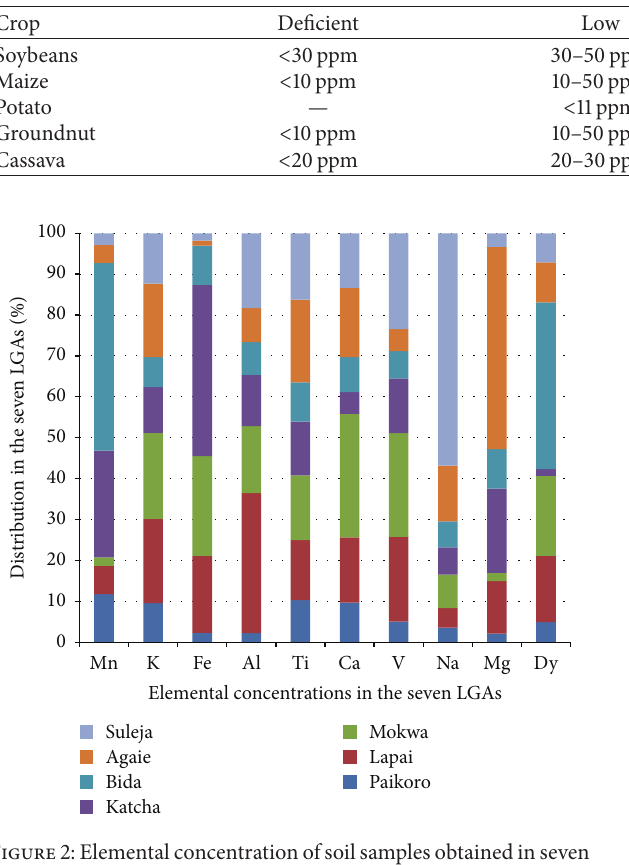
Table 7: Iron plant-analysis interpretations for common Guinea Savannah crops [34].